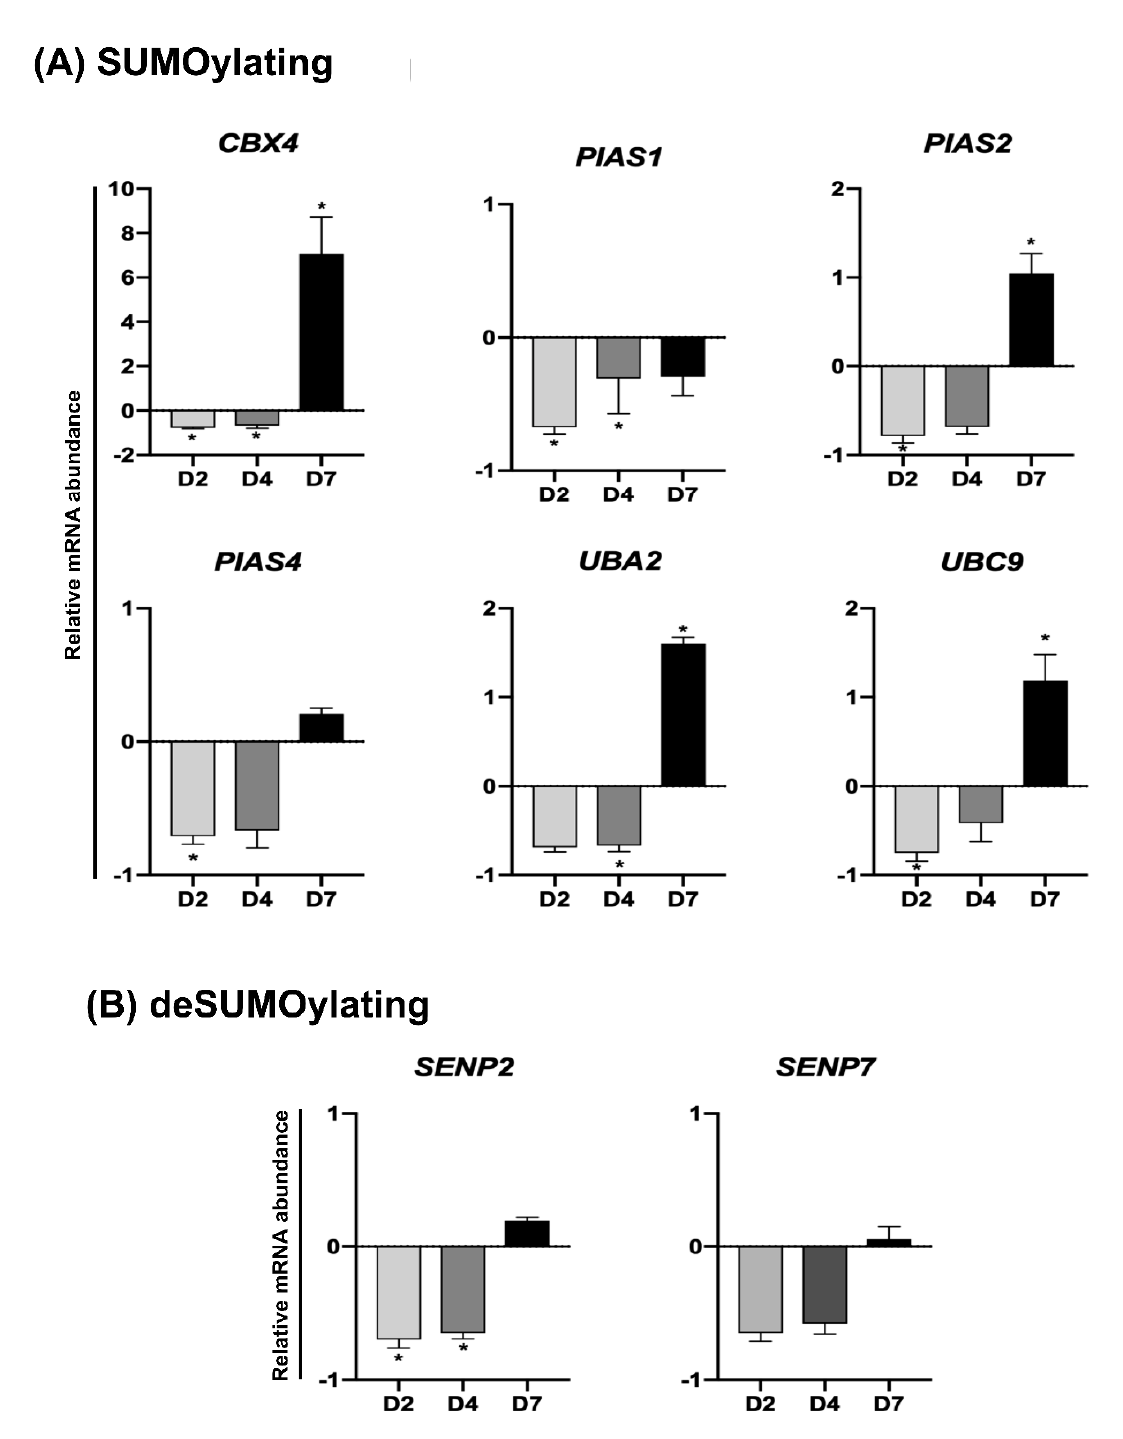
Figure 5. Relative mRNA abundance of genes encoding SUMOylation ( A ) and deSUMOylation ( B ) enzymes in porcine embryos treated with UV at different stages of development. The abundance of transcripts is presented in relation to the levels observed in control embryos (not treated with UV) at the same developmental stage. D2, day 2 embryos; D4, day 4 embryos; D7, day 7 blastocysts. Asterisks indicate statistical differences ( p < 0.05) between control and UV-treated